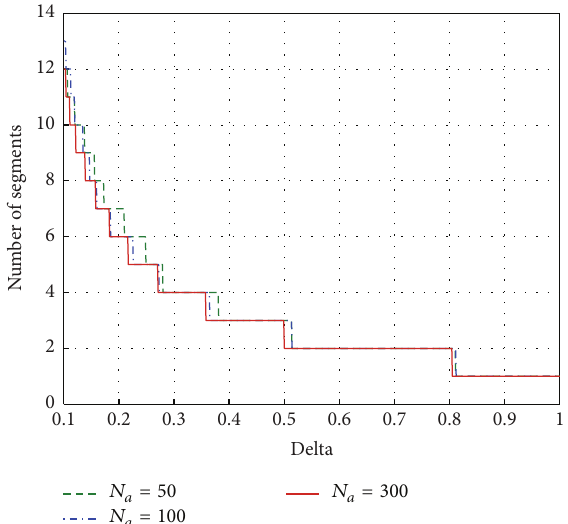
Figure 11: Number of segments depending on 𝛿 (parameter 𝑁 𝑎 ).